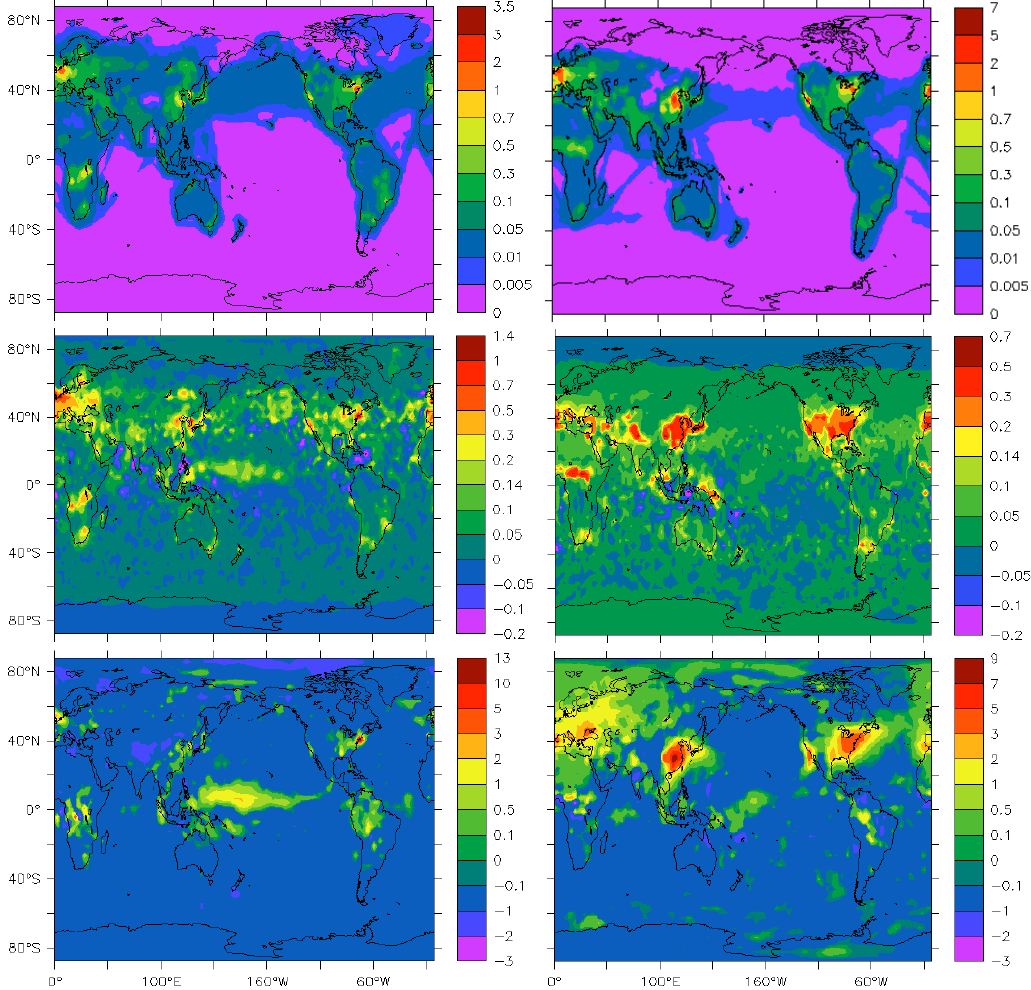
Figure 15: Simulated monthly average enhancement of OH (middle panel, 10 6 molecules cm - 3 ) and ozone (lower panel, ppbv) near the surface, indicating the difference between the S2 and base scenarios as a function of NO (base scenario, upper panel,ppbv) in June (left) and December